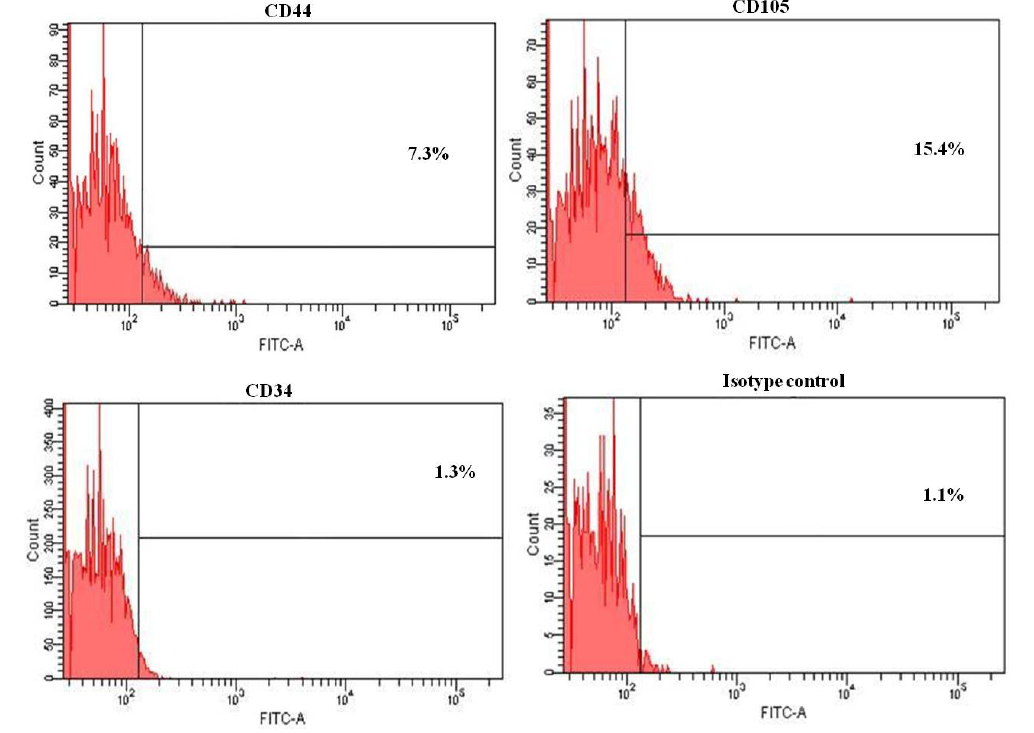
Figure 4. Expression profile of HERS cells by flow cytometry analysis. HERS cells display low expression of mesenchymal markers (CD44 and CD105) with absence of CD34